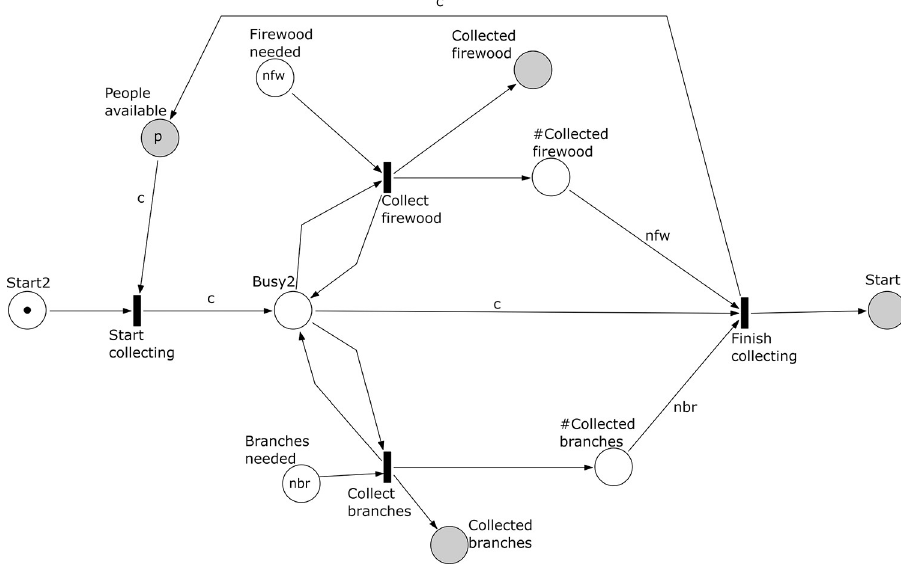
Fig 4. Subprocess 2 Collect Firewood And Branches of the A . coranica